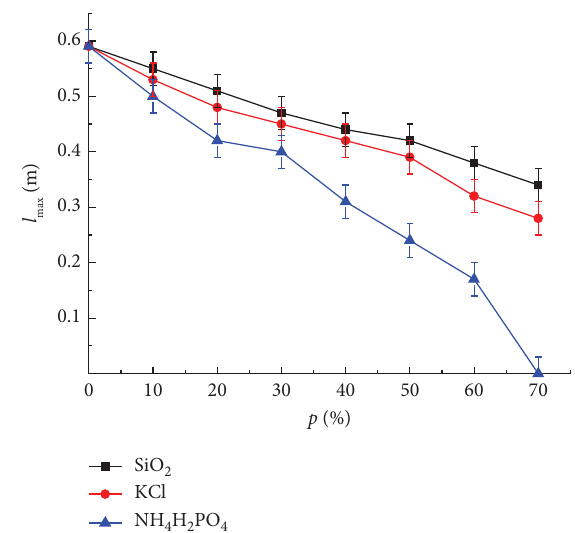
Figure 6: Inhibition of an explosion suppressant on the maximum fame propagation